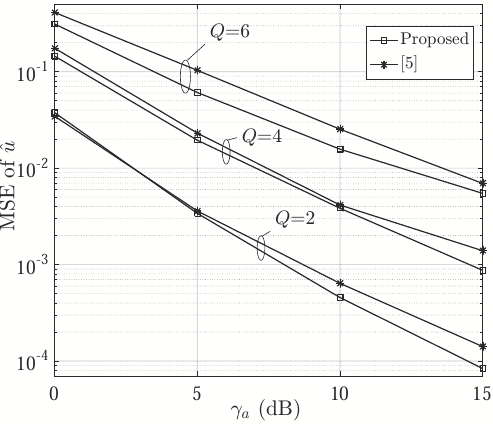
Figure 6. MSE of ˆ u versus γ a , ( N = 24 and T =